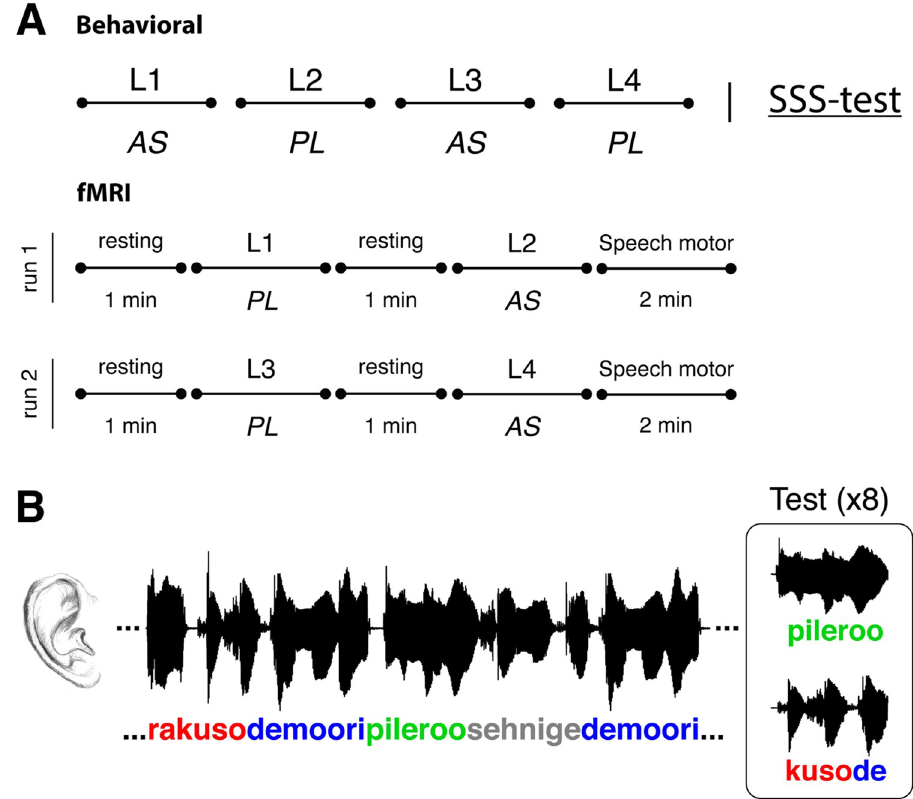
Fig 5. Overall experimental design. (A) The behavioral protocol consisted in 4 blocks of statistical word-form learning (each comprised a different pseudo-language) followed by the SSS test. The statistical word learning blocks were completed under 2 different conditions: PL, wherein participants passively listened to the pseudo-languages and AS, where participants concurrently, and repeatedly, whispered the syllable “tah”. Conditions were interleaved and the order (AS–PL–AS–PL or PL–AS–PL–AS) was counterbalanced across participants. Lower panel: for the fMRI session, 2 speech motor and 4 rest blocks were added to the behavioral protocol. (B) Schematic representation of a statistical word learning block. Left panel: learning phase. Participants listened to the 2-minute-long auditory stream containing the 4 words of the pseudo-language. Right panel: test phase. Learning was assessed after each pseudo-language exposure by an 8 trial 2-alternative forced choice test contrasting a word, upper line, and a part-word, lower line. AS, articulatory suppression; PL, passive listening; SSS test, Spontaneous Speech Synchronization